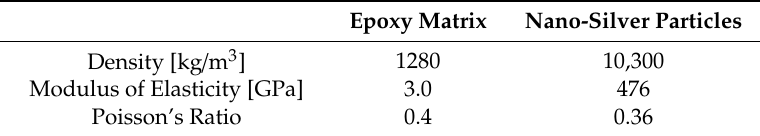
Table 2. Mechanical properties of nano-silver particles and the polymer matrix. Epoxy